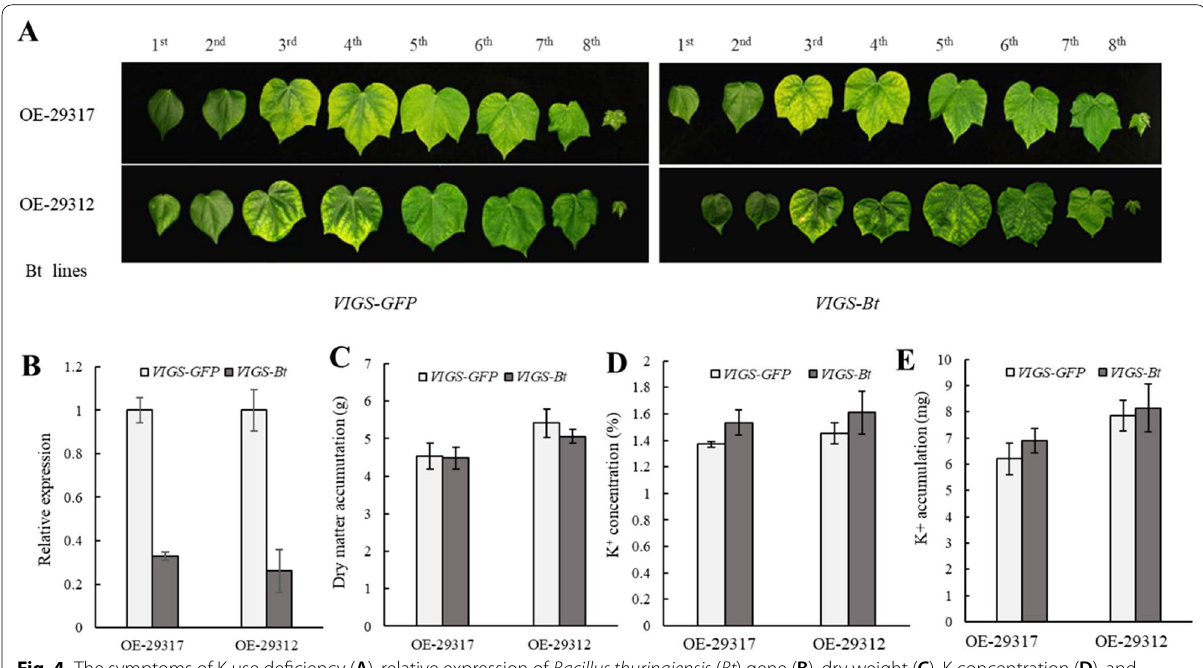
Fig. 4 The symptoms of K use deficiency ( A ), relative expression of Bacillus thuringiensis ( Bt ) gene ( B ), dry weight ( C ), K concentration ( D ), and accumulation ( E ) in leaves of transgenic Bt lines whose Bt gene was knocked down by virus-induced gene silencing (VIGS)